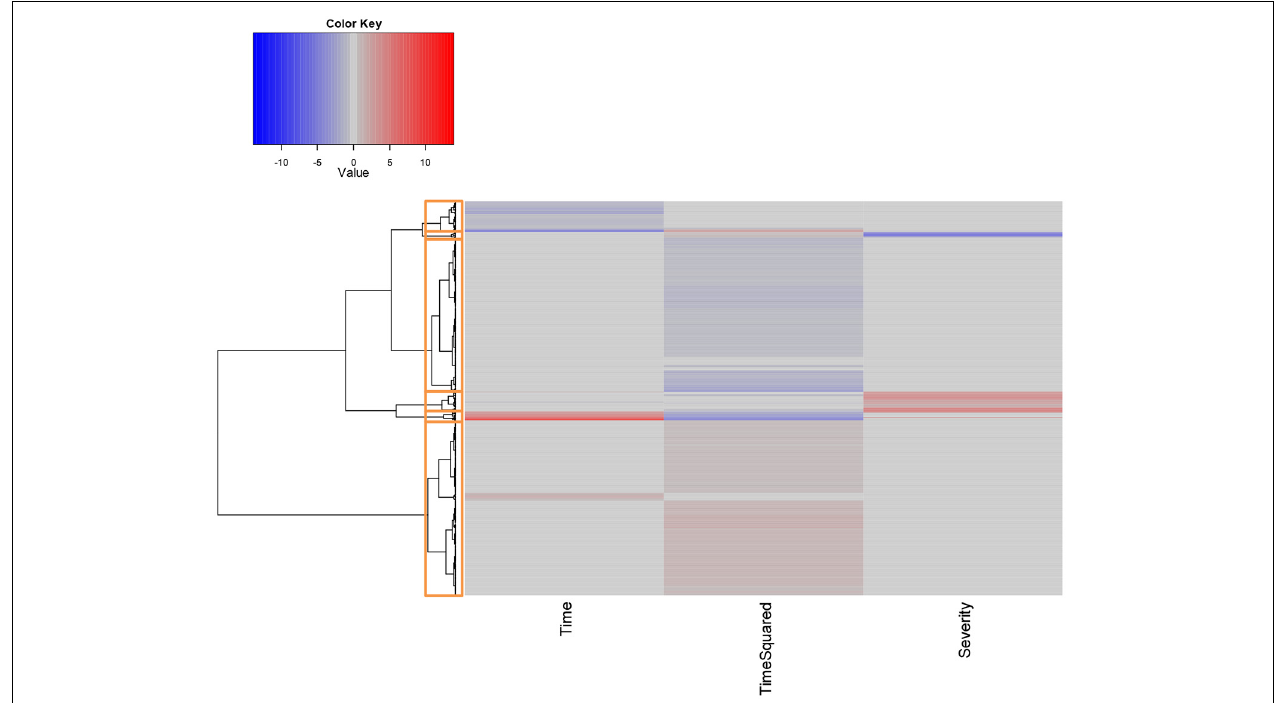
FIGURE 4 | Hierarchical clustering of unique probe IDs based on fitted model coefficients. All coefficients were scaled prior to analysis to assign equal weight to each covariate. Red values denote coefficients that are